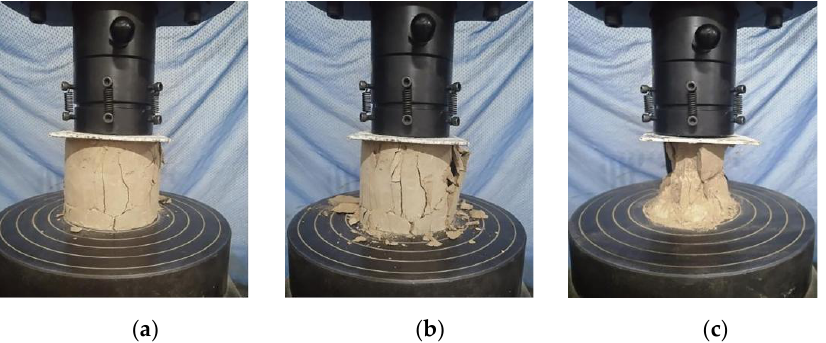
Figure 7. Test typical mode of failure in an uniaxial compression for cylindrical specimen: ( a ) middle stage of loading; ( b ) load to peak load; and ( c ) failure stage.